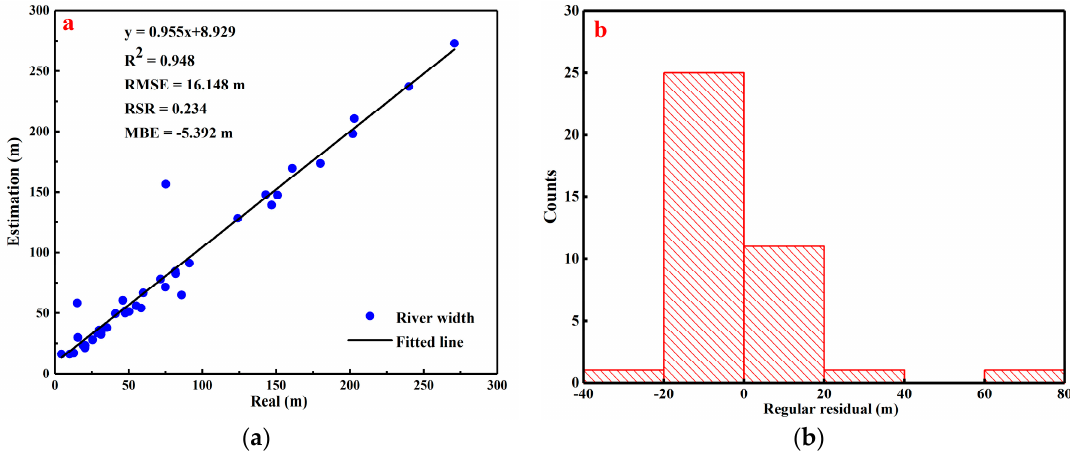
Figure 10. Comparison of river width estimations with in situ data. ( a ) represents the fitting e ff ect and the value of each statistical parameter, while ( b ) represents the